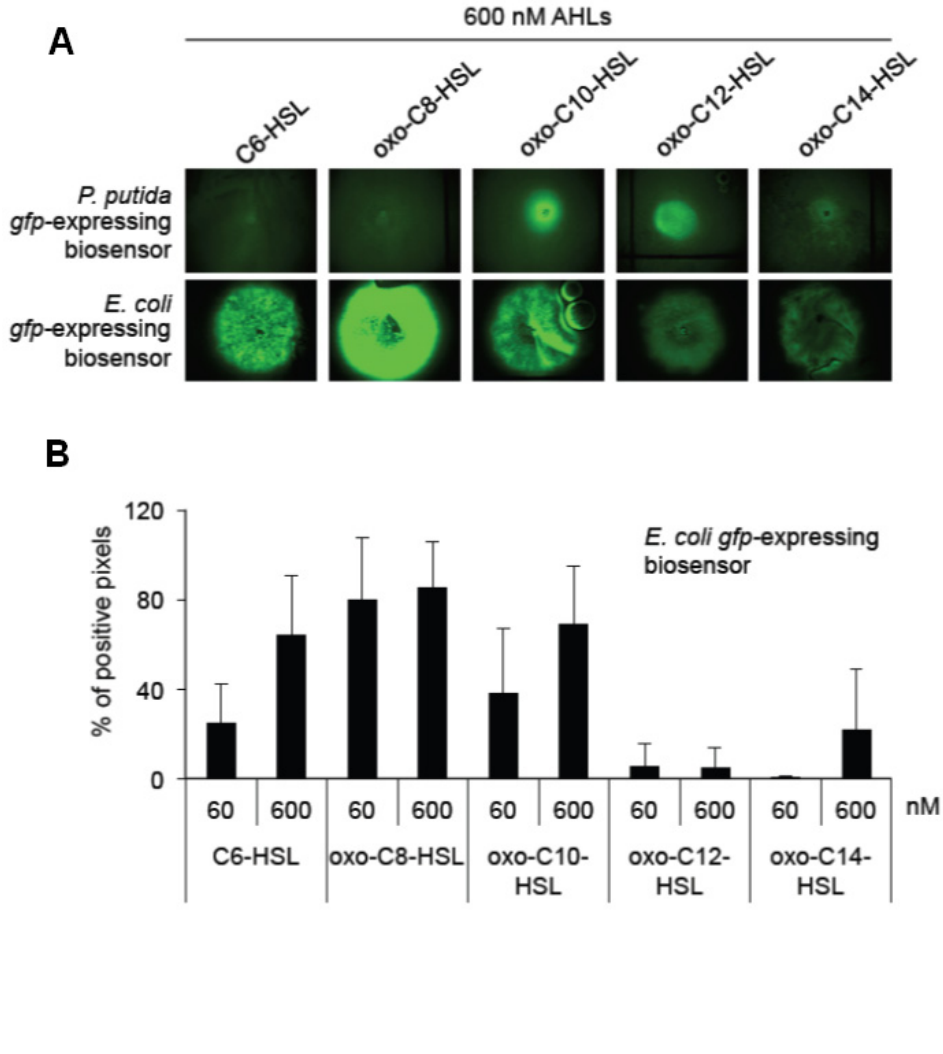
Figure S1. Detection and quantification of standard AHLs using the bacterial biosensor strains P. putida KS35 and E. coli E. coli MT102 (pJBA89). ( a ) The GFP-based system using the P. putida KS35 and E. coli MT102 (pJBA89) strains. AHLs were purchased from Sigma-Aldrich, resuspended in Me CO at concentrations as indicated and 5 µL of the 2 solution were applied onto bacterial lawns; ( b ) Quantification of the GFP photographs using the segmentation algorithm